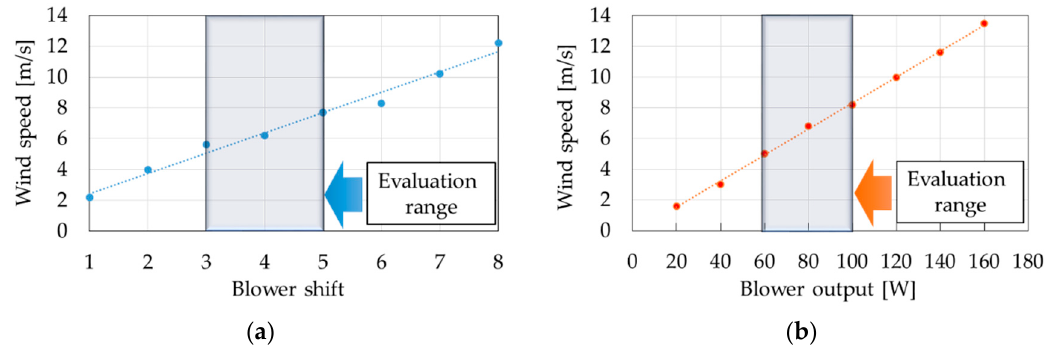
Figure 13. Comparison of wind speeds: ( a ) Blower of compact car; ( b ) Blower output of evaluation facility.